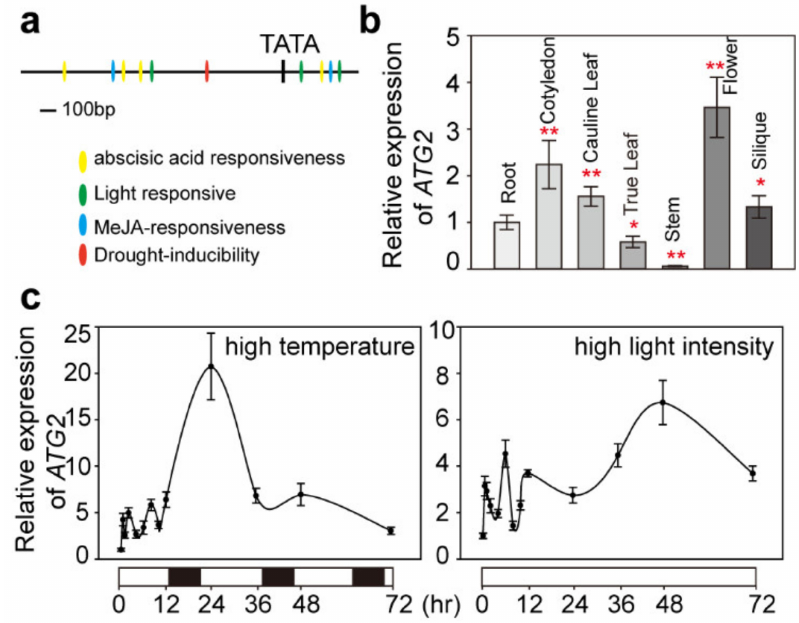
Figure 5. Cis-acting regulatory and expression pattern of ATG2 . ( a ) Cis-acting regulatory elements analyzed by Plant CARE. The bar represents 100 bp of nucleic acids; ( b ) Expression pattern of ATG2 in various organs analyzed via quantitative RT-PCR. Values are mean ± SE. Asterisk indicates significant di ff erence from the wild type at ** p < 0.01 (Student’s t test); ( c ) Expression levels of ATG2 induced by high light intensity and high temperature stresses. WT plants were grown on 1 MS medium containing 2 1% sucrose under normal conditions for 10 days, then exposed to high light intensity (350 µ mol · m − 2 · s − 1 ) or high temperature (30 ◦ C). White bars denote lighted intervals and black bars denote